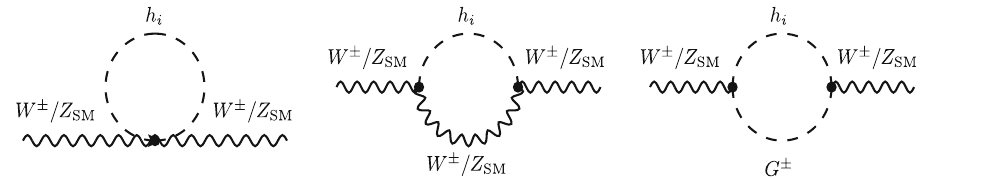
Fig. 3 Vacuum polarization diagrams that contribute to the oblique parameters from the mixing between the SM doublet H 1 and the hidden doublet (cid:4)